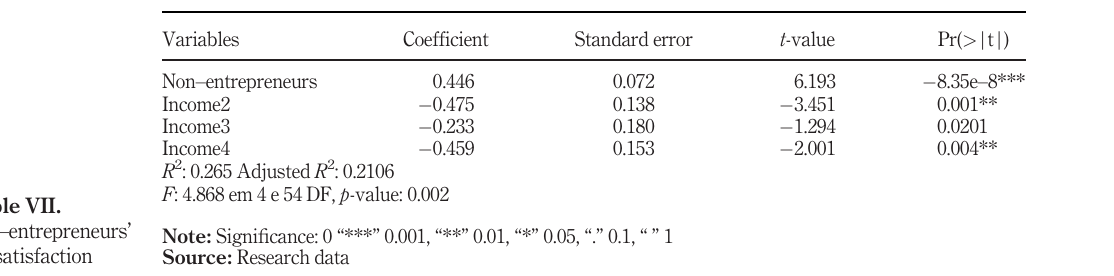
Table VII. Non – entrepreneurs ’ job satisfaction